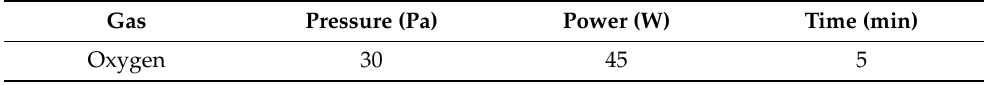
Table 1. Plasma treatment